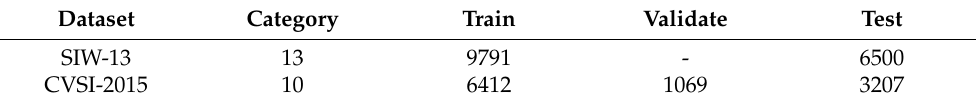
Table 2. Image category and number in the dataset.